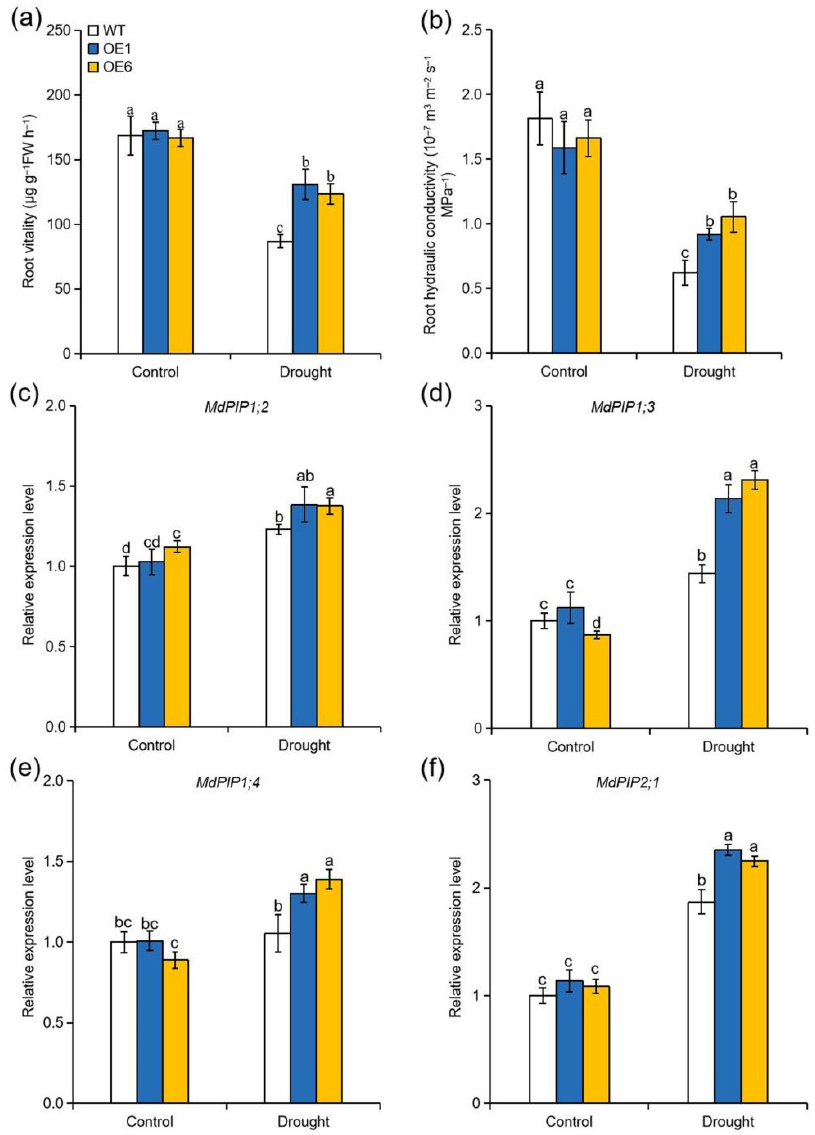
Figure 7. Effect of MdATG8i overexpression in apple on root water uptake under drought conditions. ( a ) Root vitality and ( b ) root hydraulic conductivity of the WT and MdATG8i OE plants after 4 d of drought treatment. Change in the expression levels of ( c ) MdPIP1;2 , ( d ) MdPIP1;3 , ( e ) MdPIP1;4 , and ( f ) MdPIP2;1 in the roots of WT and transgenic plants after 4 d of drought treatment. The data are presented as means ± SD of three replicates. Values with different letters are significantly different ( p < 0.05, Tukey’s multiple range test).